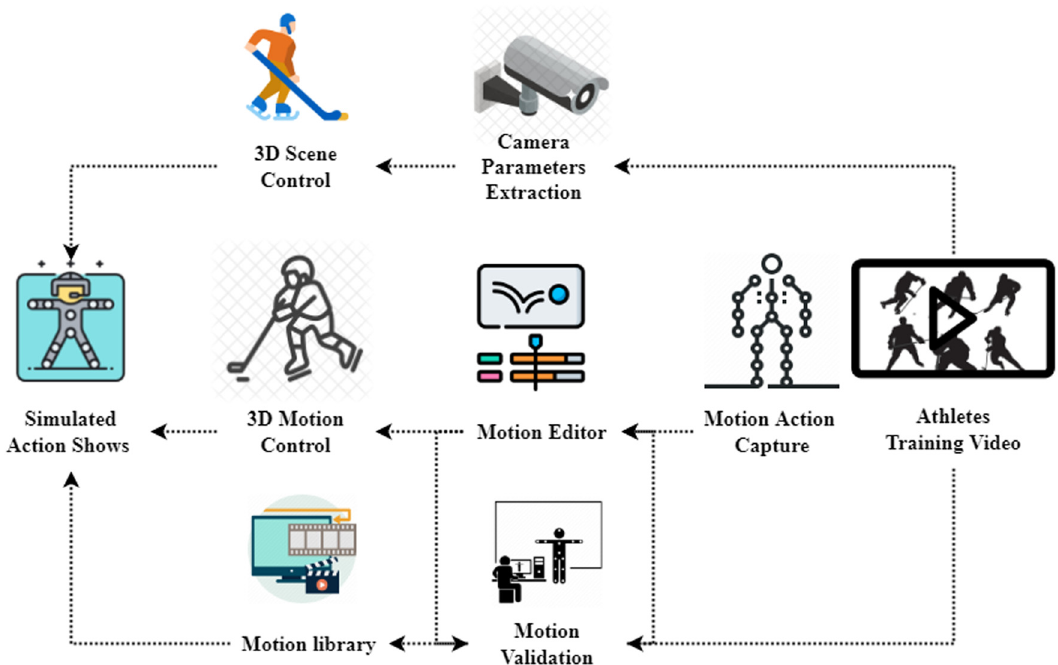
Figure 3: Human - centered arti fi cial intelligence - based sports categorization system based on web 4.0